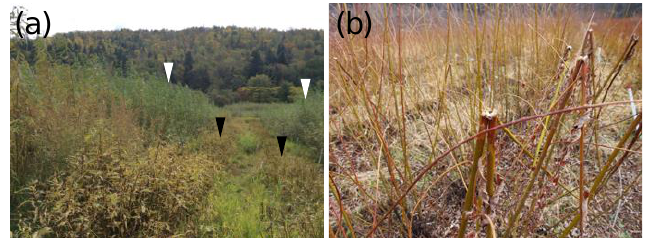
Figure 2. Willow stem tips browsed by Yezo-sika deer in the experimental short rotation coppice. Planting rows of a clone with minimal browsing (white inverted triangles) adjacent to rows of a severely browsed clone (black inverted triangles) ( a ). Willow stems broken by Yezo-sika deer while browsing willow stem tips ( b ).